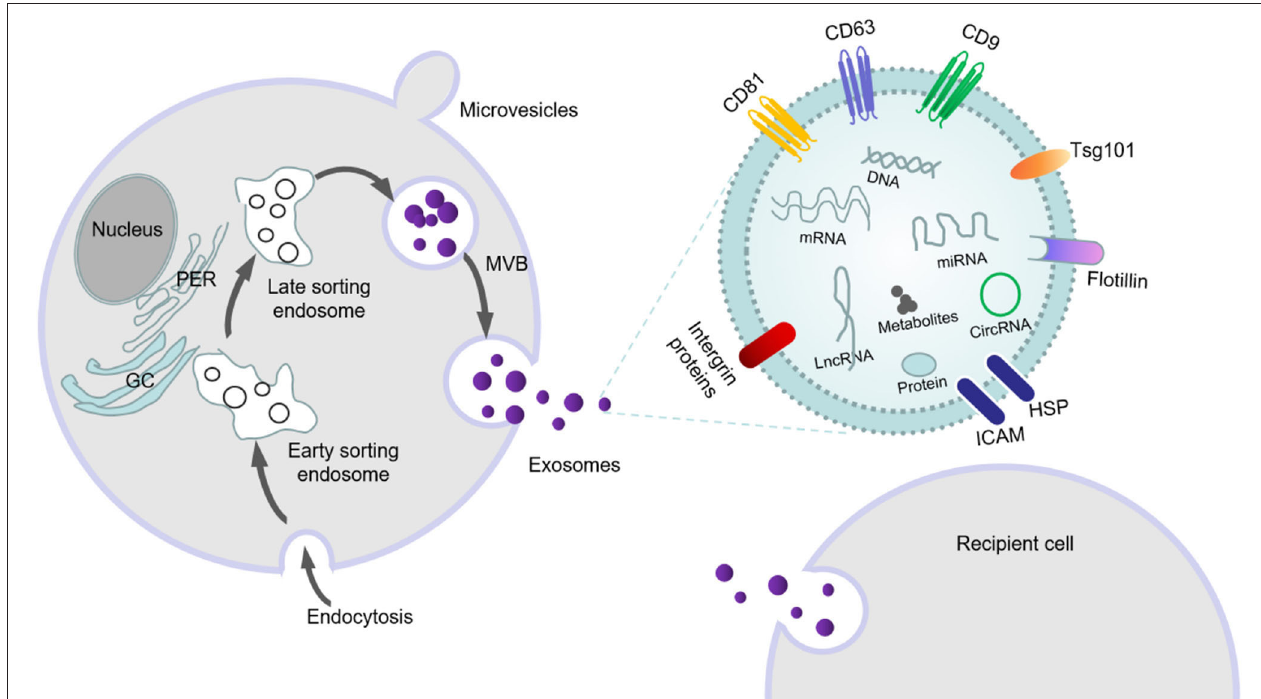
FIGURE 1 | The formation, secretion and swallowing of exosomes, as well as the substances carried by exosomes.